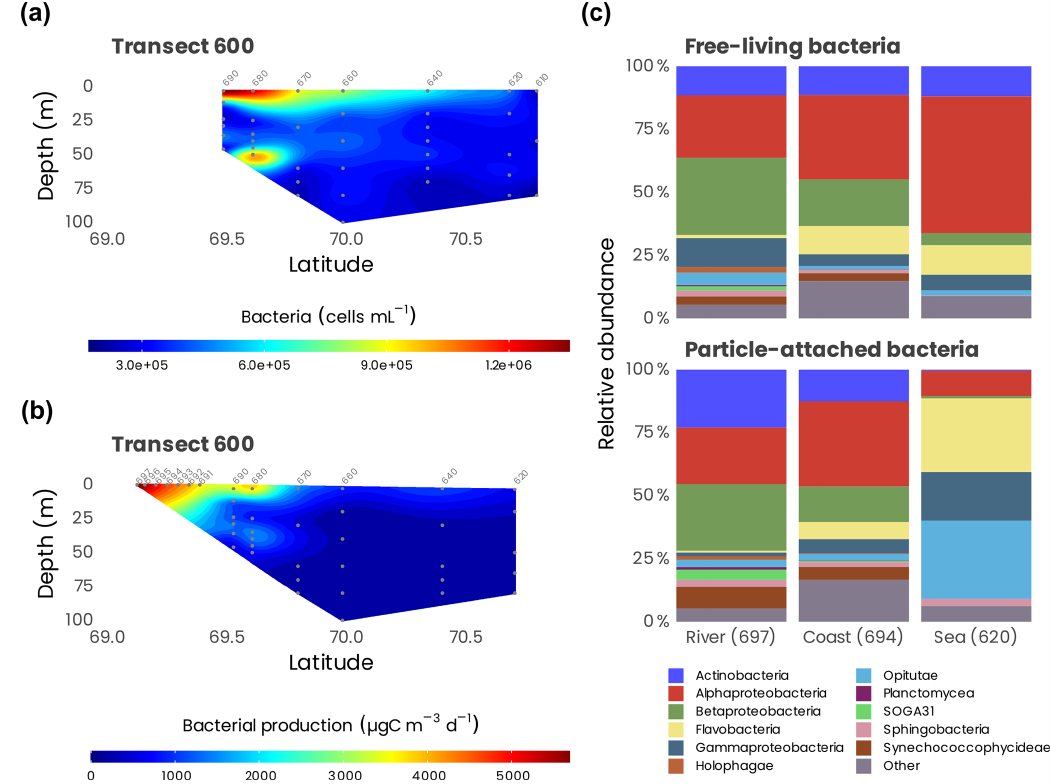
Figure 15. (a) Cross-sections of bacterial abundance measured from flow cytometry and (b) bacterial production measured along transect 600. Station numbers are identified in light gray on top of each panel. (c) Cumulative bar charts comparing the relative class abundances in particle-attached (PA) and free-living (FL) bacteria for a selected number of samples in transect